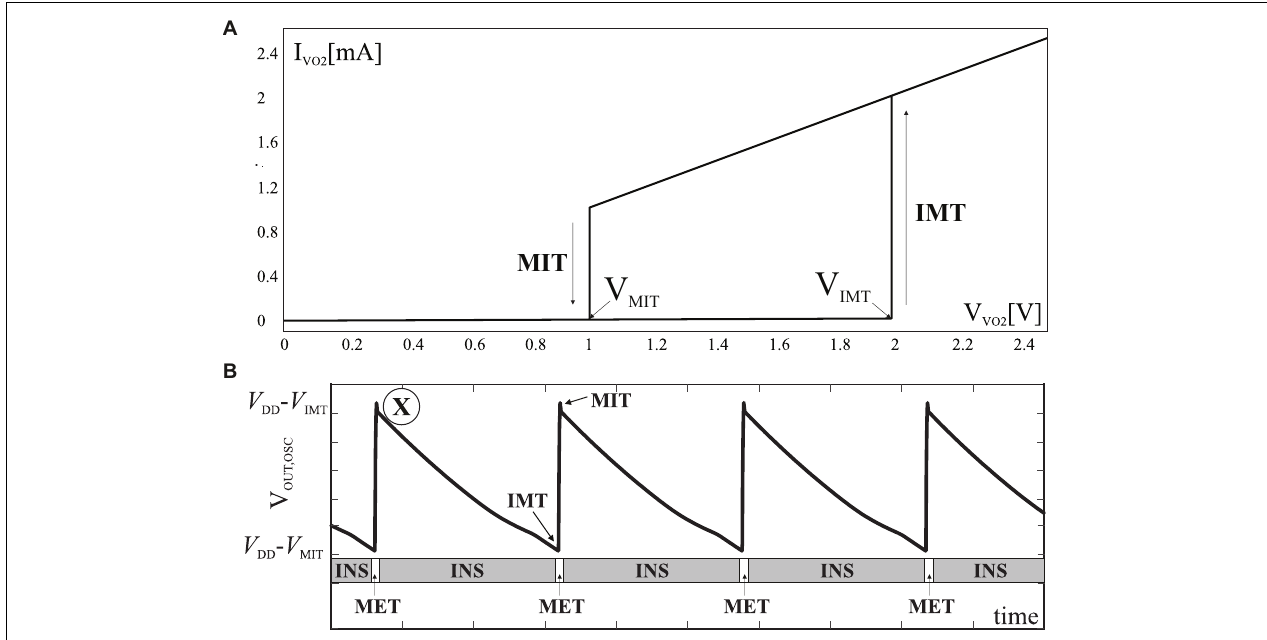
FIGURE 2 | (A) I-V curve of the VO 2 device reported in Corti et al. (2018, 2020). (B) Simulated waveform of the output of a VO 2 oscillator.